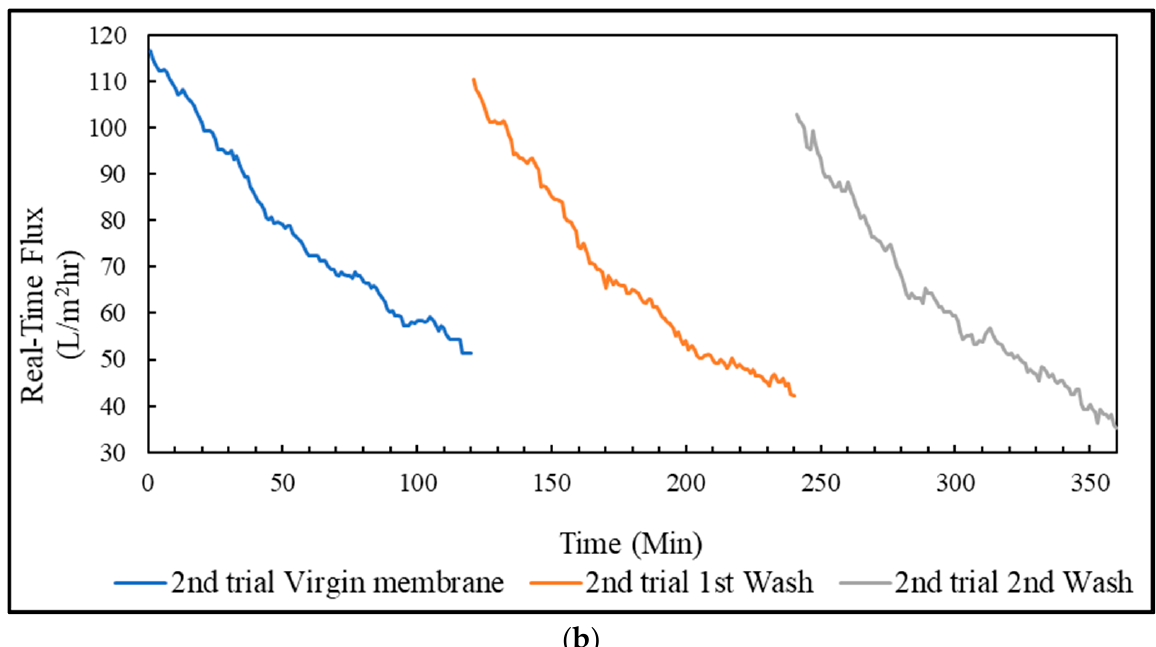
Figure 3. PSWW treatment with UF membrane: ( a ) 1st trial of UF membrane; ( b ) 2nd trial of UF membrane.